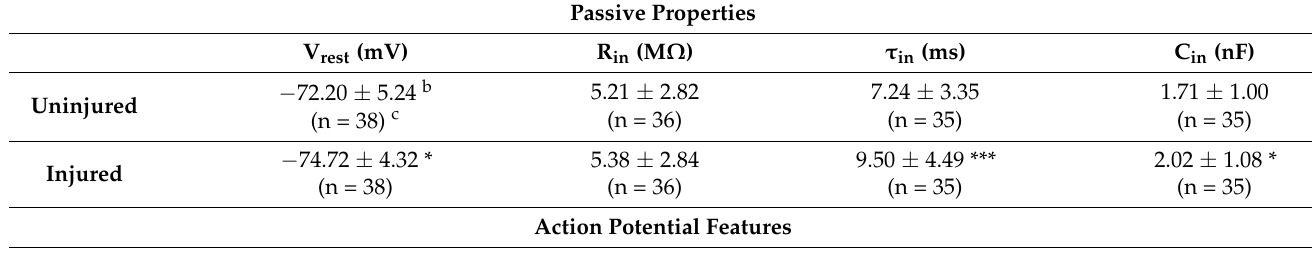
Table 3. Biophysical Properties of Uninjured and Injured Pairs of RS Neurons a at 2–3 Week Recovery Times following Right Spinal Cord HTs at 10% BL. Passive